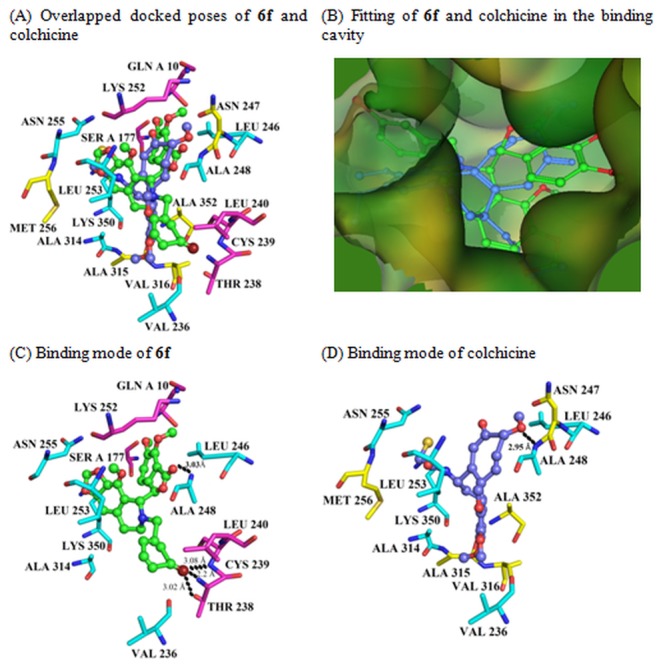
Three dimensional representation of the mode of interactions observed between the most potent noscapinoid, 6f and colchicine demonstrate distinct interaction with tubulin.
Panel A represents snapshot of overlapped docked poses of 6f (green) and colchicine (blue). The amino acids that are uniquely involved in the interaction of colchicine with tubulin are Asn 247, Met 256, Ala 315, Val 316, Ala 352 (yellow carbon). In contrast, the amino acids that are uniquely involved in the interaction of 6f with tubulin are Gln A10, Ser A177, Thr 238, Cys 239, Leu 240, Lys 252 (pink carbon). The other amino acids that are common in the interaction of both 6f and colchicine are Asn 255, Leu 253, Lys 350, Ala 314, Val 236, Ala 248 and Leu 246 (cyan carbon). Binding of colchicine has been highly biased towards β-tubulin whereas 6f partially interacts with α-tubulin as well. Panel
B represents the fitting of 6f and colchicine inside the binding cavity. Panel
C demonstrates the mode of interaction of 6f with the residues of tubulin. The ligand, 6f, distinctly interacts with the amino acid residues of tubulin in comparison to colchicine, and involves 4 hydrogen bonds (dashed lines): the bromine atom of 6f hydrogen bonded with OG1 of Thr B238 (bond length 3.02 Å), N1 of Thr B238 (bond length 2.02 Å) and N1 of Cys B239 (bond length 3.08 Å). Similarly, the oxygen atom of the isobenzofuranone ring of 6f hydrogen bonded with N1 of Ala B248 (bond length 3.03 Å). Panel
D shows the binding mode of colchicine with tubulin. The interaction of colchicine with the residues of tubulin involves only one hydrogen bond (dashed line) between the oxygen atom of one of the methoxy group of colchicine with N1 of Ala B248 (bond length 2.95 Å). Only those amino acids that are within 4.5 Å distances from the docked ligands are shown.